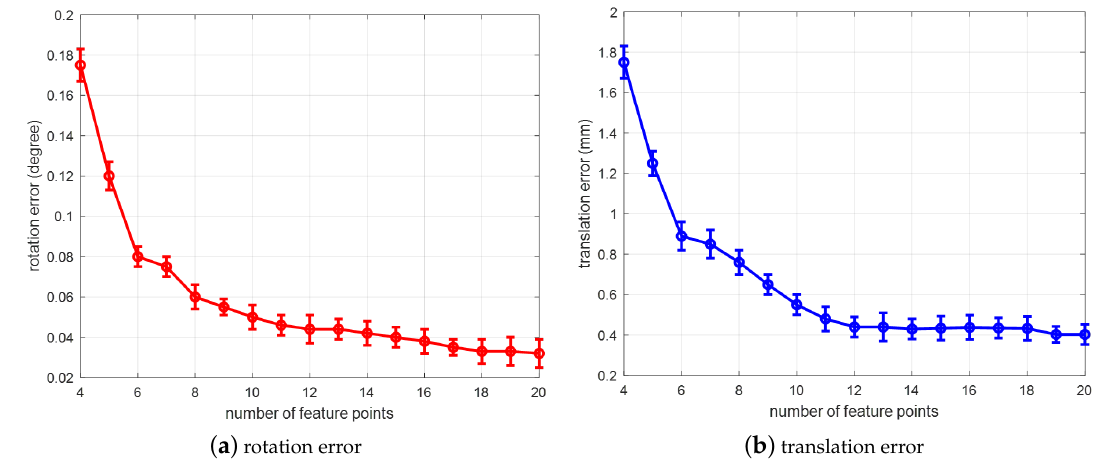
Figure 6. Influence of number of feature points on multi-view-based pose estimation: ( a ) rotation error; ( b ) translation error.